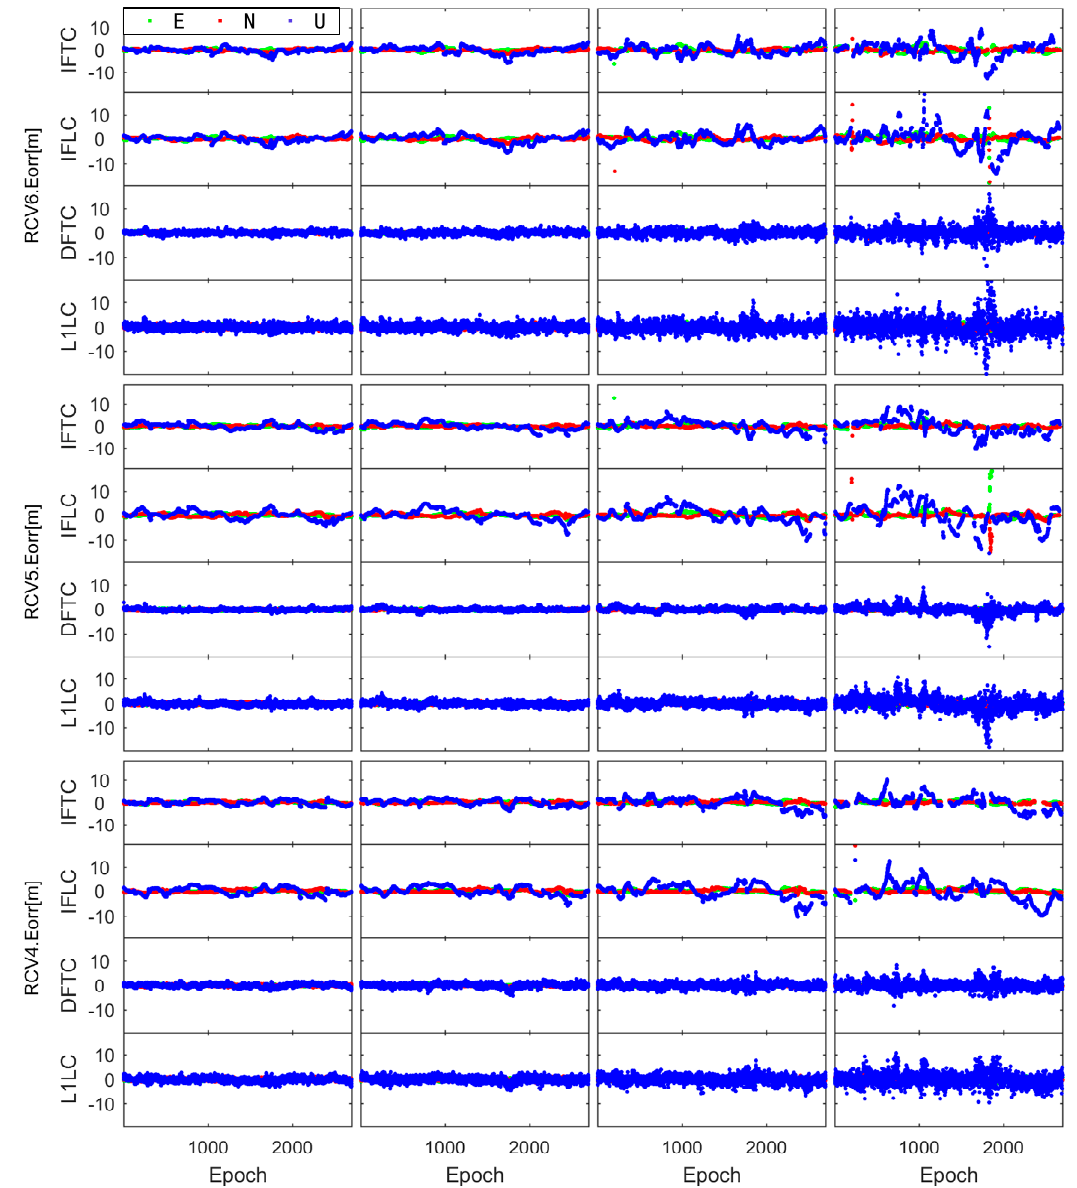
Figure 7. Positioning errors with different cutoff elevation angles (m). The rows from top to bottom are positioning errors of the receiver pairs RC4, RC5, and RC6 from the L1LC, DFTC IFLC, and IFTC methods. Note that eastern errors are represented by green points, northern errors are represented by red points, and vertical errors are represented by blue points. The columns from left to right correspond to different cutoff elevation angles (15°, 25°, 35°, and 45°).